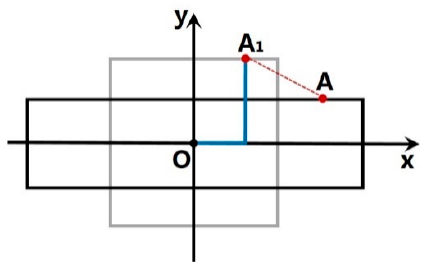
Figure 5. Different appearances of the square in Chebyshev space and Chebyshev space with axial scale.